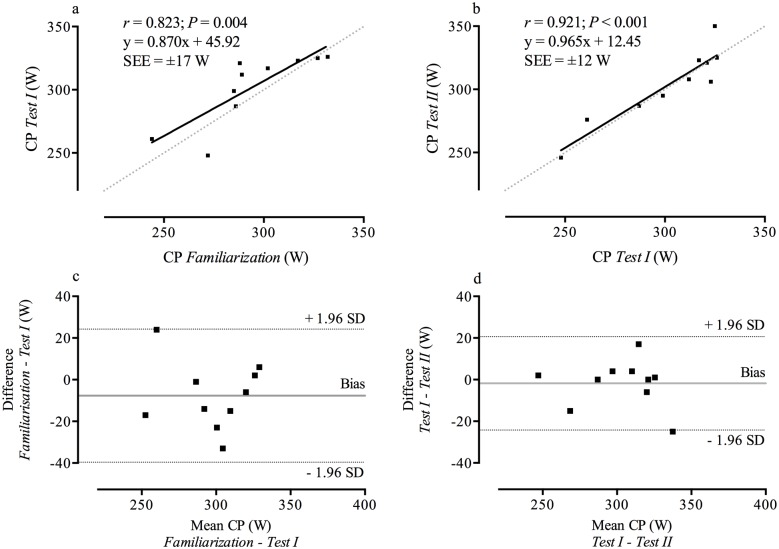
Relationships (panels a and b) and Bland-Altman plots of the differences (panels c and d) between repeated tests of CP.The black solid line represents the linear regression and the grey-dotted line represents the line of identity (panel a and b). The solid grey line represents the mean bias and the dotted black line represent the 95% limits of agreement (panel c and d).